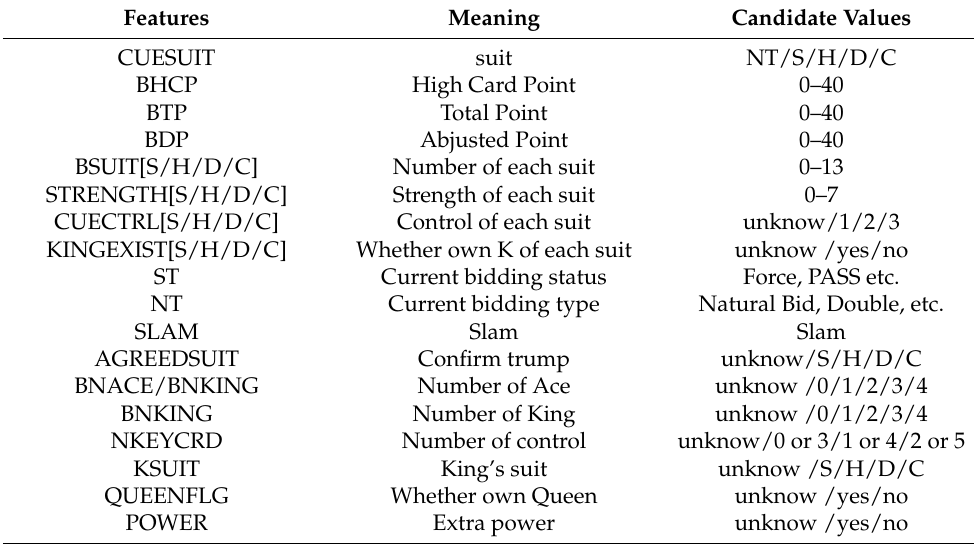
Table 1. Valid information and its meaning and candidate